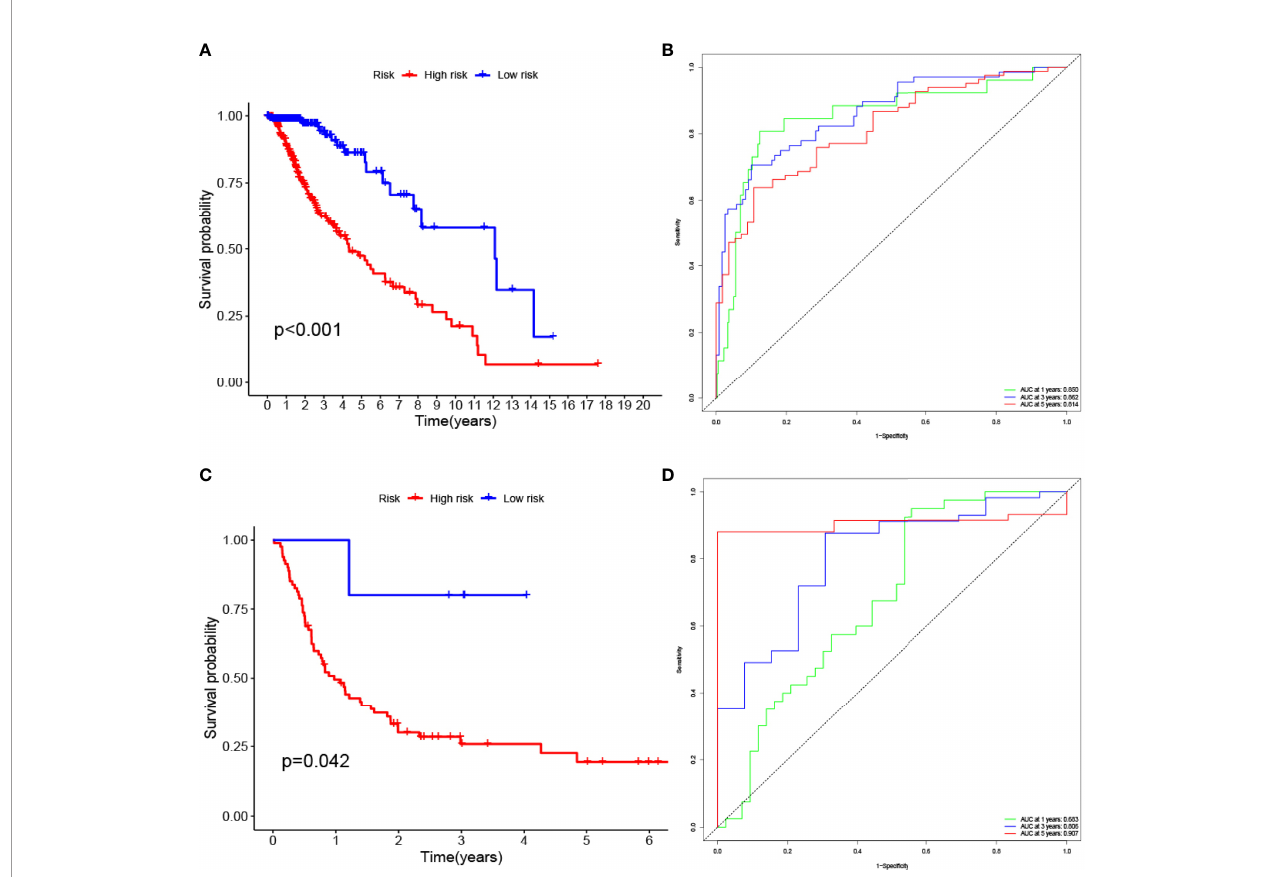
FIGURE 8 | High risk score among glioma patients were associated with low overall survival (p-value < 0.05 was considered statistically signi fi cant). The AUC (Area Under roc Curve) value of ROC indicates that 0.5-0.7 is acceptable, 0.7-0.9 is good, and> 0.9 is excellent. (A) K-M curves of the glioma (TCGA) risk score model. (B) glioma (TCGA) ROC curve. (C) K-M curves of the glioma (GEO GSE4412) risk score model. (D) glioma (GEO GSE4412) ROC